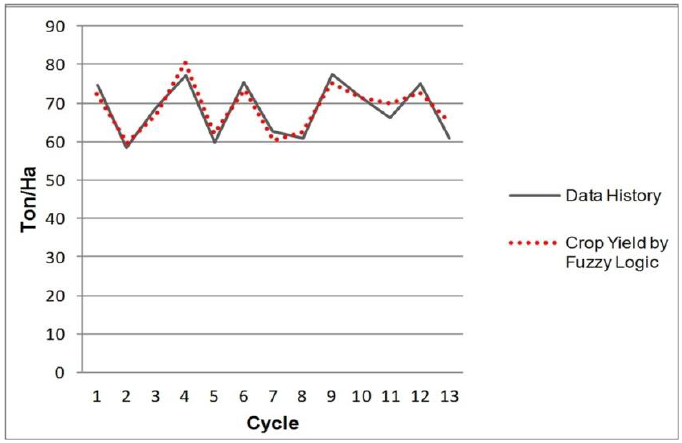
Figure 7. Sugar cane yield: data history–VS-fuzzy logic model data.